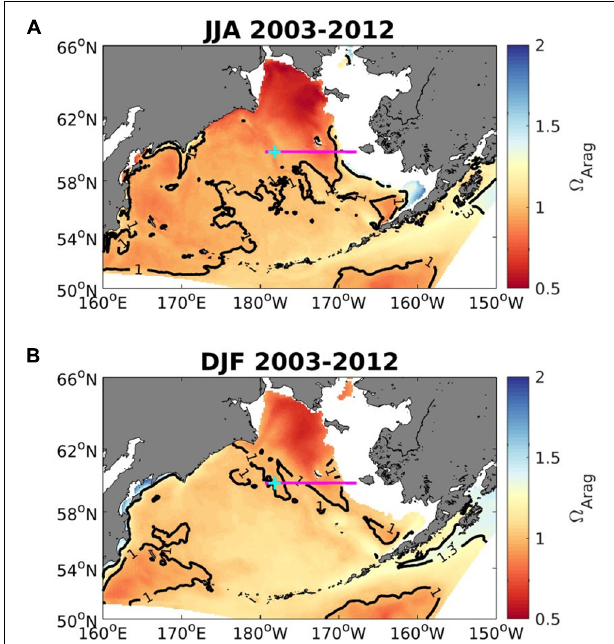
FIGURE 7 | Average seasonal aragonite saturation state ( (cid:127) ar ) across the upper 50 to 100 m in the Bering Sea for June to August ( A ; upper) and December to February ( B ; lower), averaged over 2003-2012 (modeled data). Solid black contour lines depict aragonite saturation state equals 1 and 1.3. White areas show locations shallower than 50 m. Magenta line shows the midnorth (MN) shelf transect, and cyan plus-sign denotes the MN18 station location. Model output is from the Bering10K hindcast simulation described by Pilcher et al.